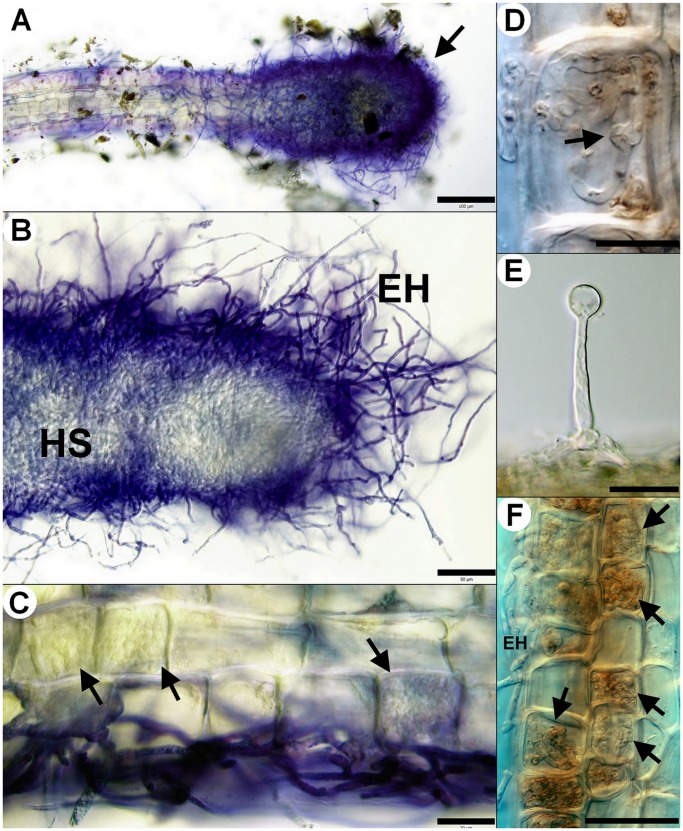
Morphological and anatomical characteristics of sheathed ericoid mycorrhiza synthesized in vitro and observed under natural conditions.Sheathed ericoid mycorrhiza was synthesized in vitro between the basidiomycetous mycobiont (strains JPK 87 and JPK 90) and European blueberry (Vaccinium myrtillus) seedlings or observed in European blueberry hair roots collected in field. 3A) Terminal part of hair root is covered by a dense hyphal sheath (arrow). JPK 87, DIC, stained with trypan blue, bar  = 100 µm. 3B) Detail of a dense hyphal sheath (HS) covering terminal part of a hair root. Note the extensive extraradical hyphae (EH). JPK 90, DIC, stained with trypan blue, bar  = 50 µm. 3C) Dense intracellular hyphal coils (arrows) developing in the rhizodermal cells below a hyphal sheath. JPK 90, DIC, stained with trypan blue, bar  = 20 µm. 3D) Clamp connection (arrow) formed by the basidiomycete inside a rhizodermal cell. Roots from field, DIC, bar  = 10 µm. 3E) Terminally swollen capitate cystidium emerging from a sheathed ericoid mycorrhiza. Roots from field, DIC, bar  = 10 µm. 3F) Vigorous intracellular colonization (arrows) by the basidiomycete accompanied by numerous extraradical hyphae (EH). JPK 90, DIC, bar  = 50 µm.